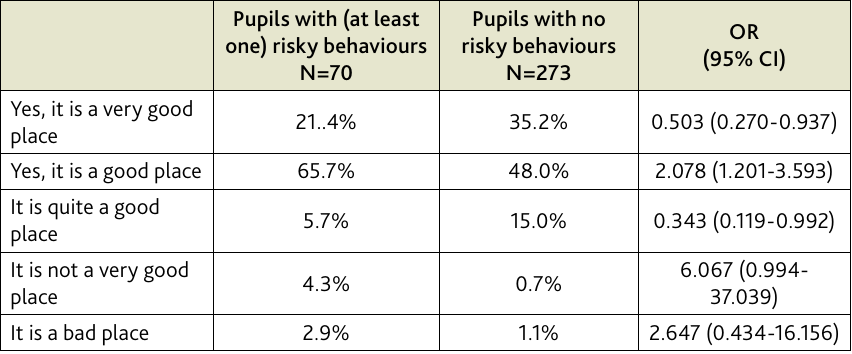
Table 4. Percentage of responses to the question “Do you think that the place you live is good to live?” of respondents with and with no risky behaviours